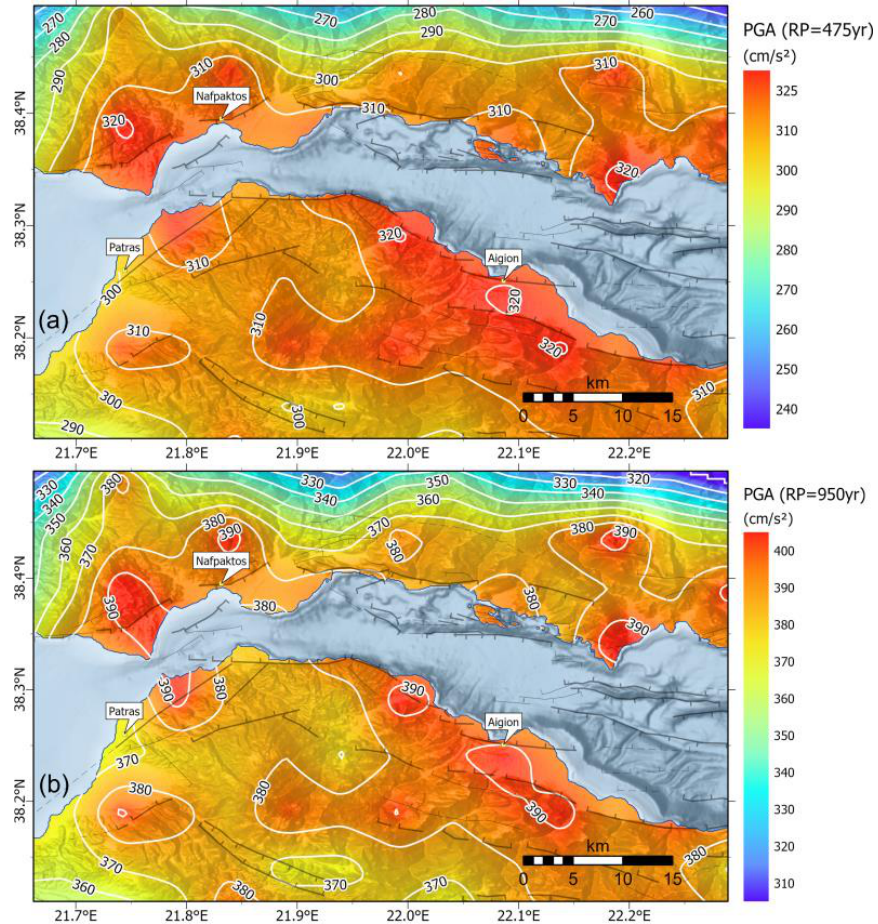
Figure 3. Spatial distribution of PGA values for a return period (RP) of ( a ) 475 yr and ( b ) 950 yr.